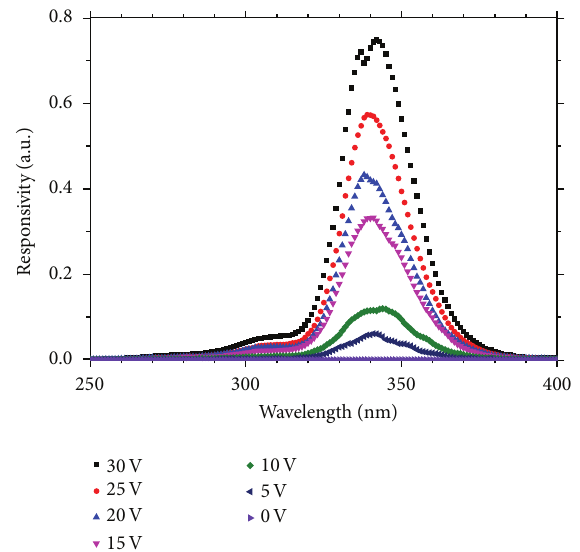
Figure 6: Spectral responsivities of the Mg 0.52 Zn 0.48 O UV-PD at different bias